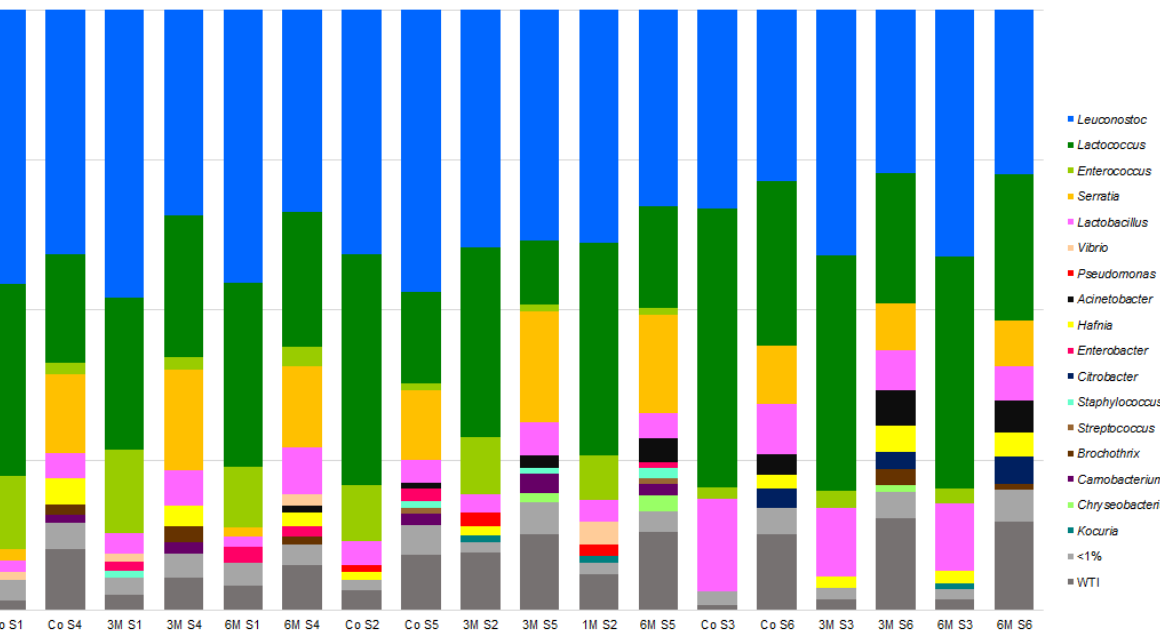
Figure 4. Relative abundances (%) of dominant sequences (>1%) assigned to genus level identified in Serra da Estrela cheese DNA samples based on partial sequence analysis of the V3–V4 region in the rRNA gene. Co refers to the commercially used cardoon by the cheese producer and 1 M, 3 M and 6 M refers to specific cardoon genotypes. WTI refers to the percentage of sequences without taxonomic attribution to the specified taxonomic level.